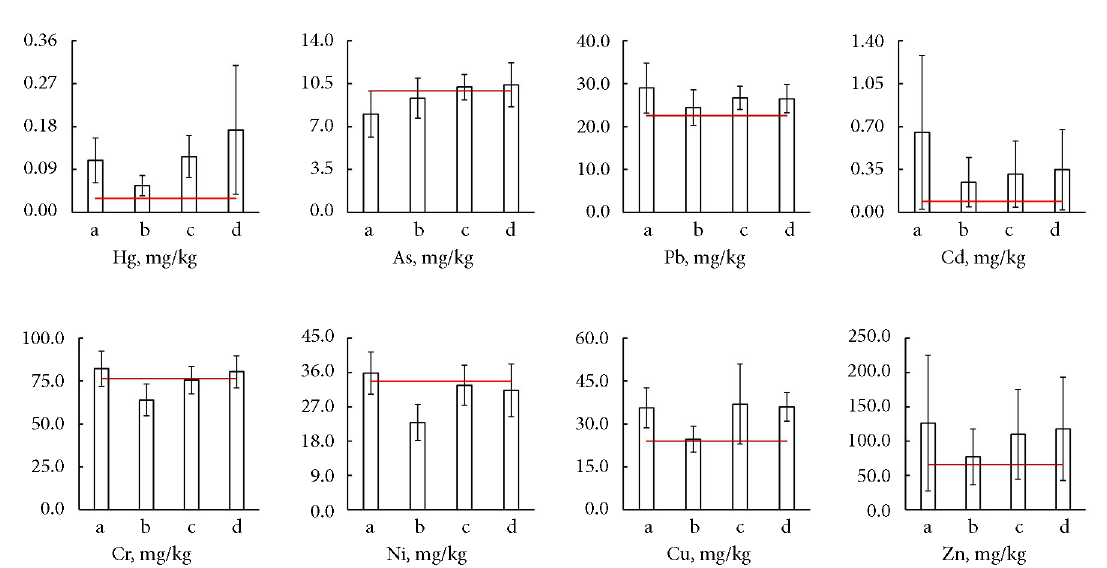
Figure 2. Heavy metal concentrations in representative areas